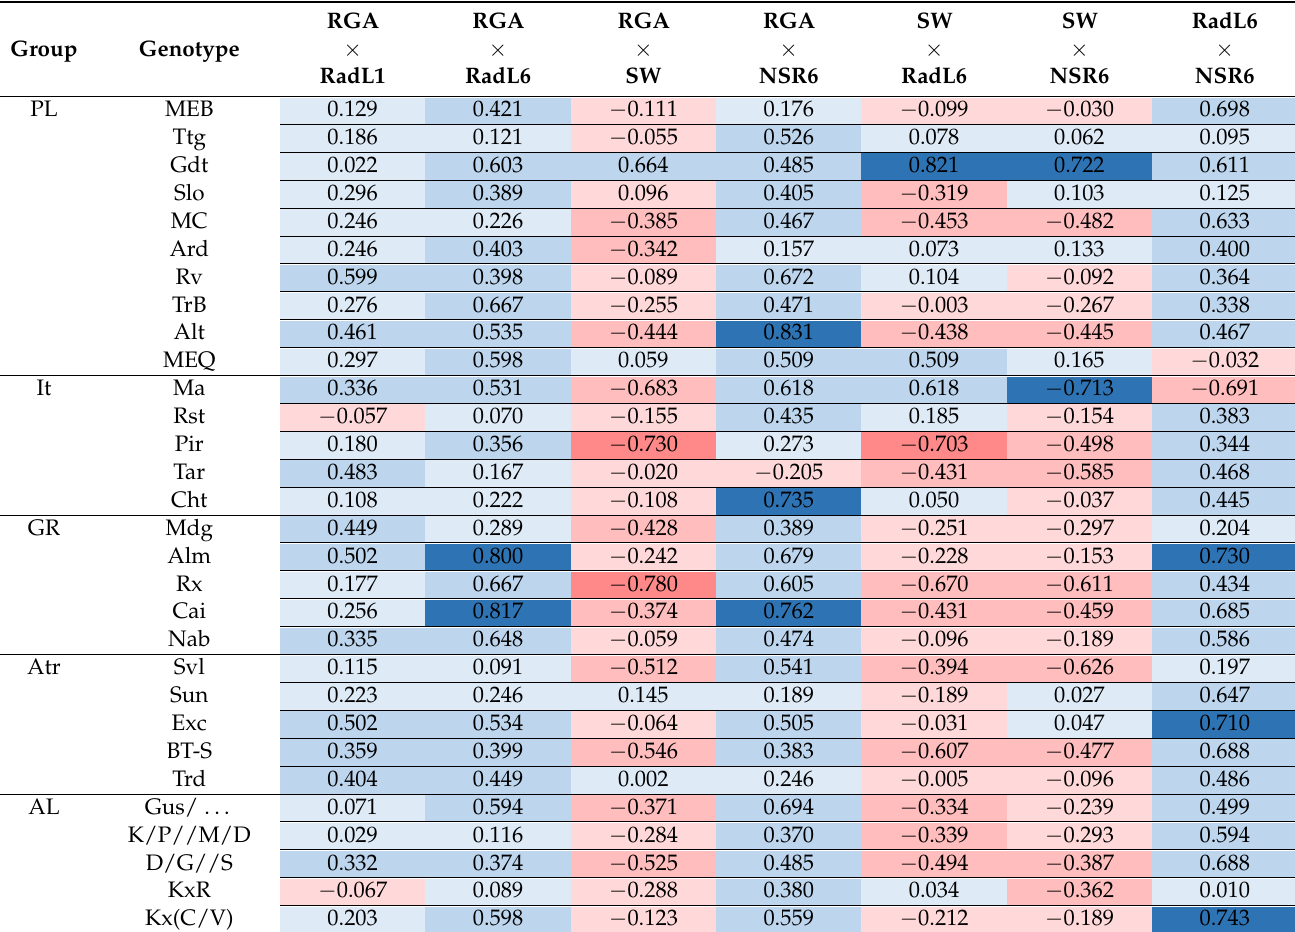
were observed for Pir and Ma (Italians), respectively. The analysis also indicates a positive coefficient between RadL6 × NSR6 in Alm (Green Revolution) and Exc (Australian). Table 3. Pearson correlation coefficient between the root growth angle with the radicle length 1 and 6 days after sowing (RGA × RadL1 and RGA × RadL6, respectively), with the seed weight (RGA × SW) and with the number of seminal roots 6 days after sowing (RGA × NSR6) as well as the correlation between seed weight with the radicle length at 6 DAS (SW × RadL6) and with number of seminal roots at 6 DAS (SW × NSR6). We also presented the value for Pearson correlation of radicle length at 6 DAS with the number of seminal roots at 6 DAS (RadL6 × NSR6); n =